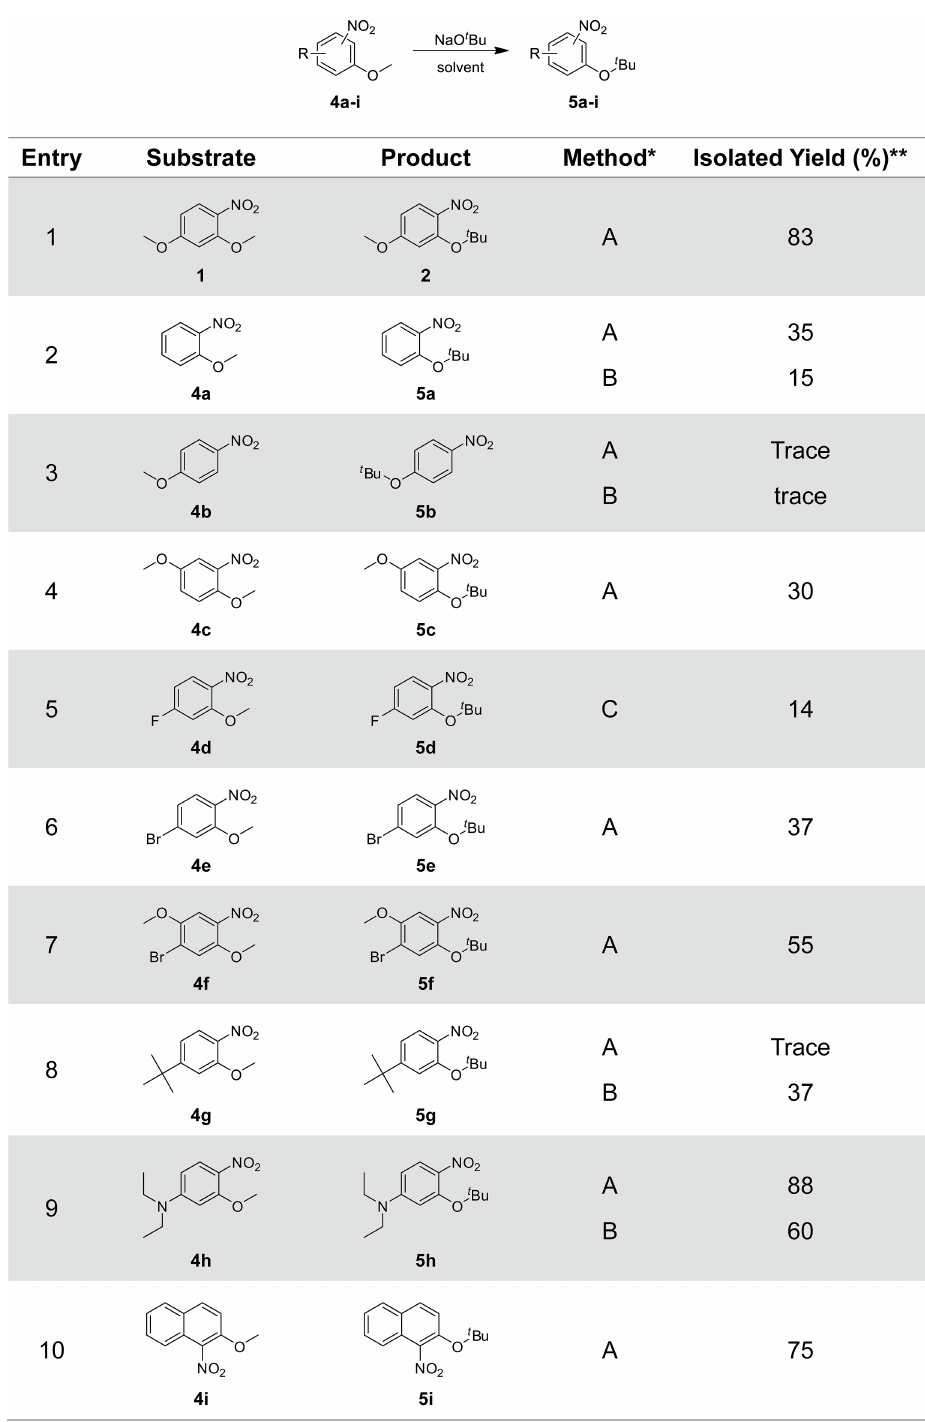
Fig 4. Transetherification of o -methoxynitrobenzenes with sodium tert -butoxide. * Methods:A. nitrobenzene derivative(0.3 mmol) and NaO t Bu (2.1 mmol) in 10% DME in toluene(1.5 mL) at 110˚C for 20 min under microwaveirradiation. B. nitrobenzene derivative(0.3 mmol) and NaO t Bu (2.1 mmol) in toluene (1.5 mL) at 110˚C for 20 min under microwaveirradiation. C. nitrobenzenederivative (0.3 mmol) and NaO t Bu (0.6 mmol) in toluene(1.5 mL) at room temperature for 5 d. ** Isolated yield after purification.